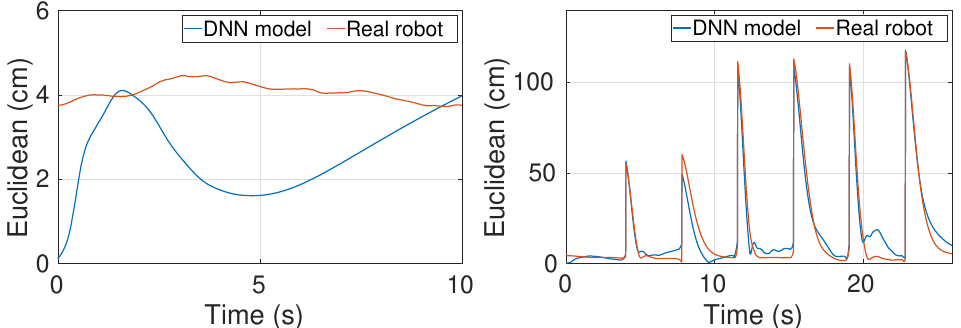
Figure 6. Euclidean errors for hover ( left ) and for sequential-setpoints ( right ) by the weight set from real flight